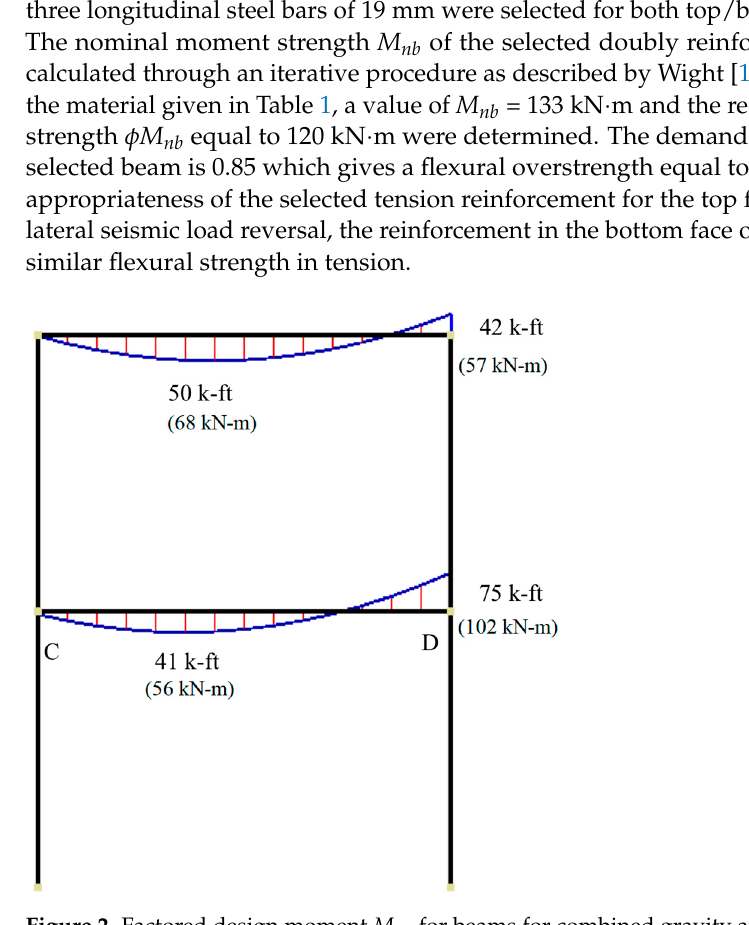
Figure 2. Factored design moment M ub for beams for combined gravity and lateral seismic forces. The factored shear force was computed in accordance with the ACI-318-19